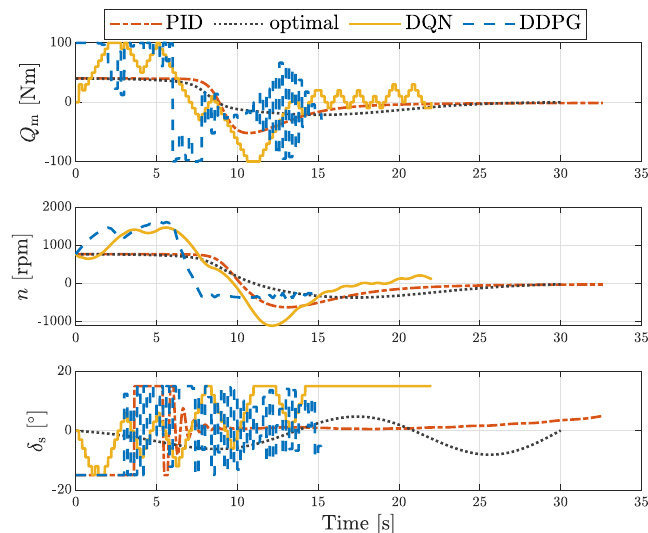
Figure 11. Input motor torque, motor rotational speed and input sternplane angle of the AUV during docking with different control strategies.